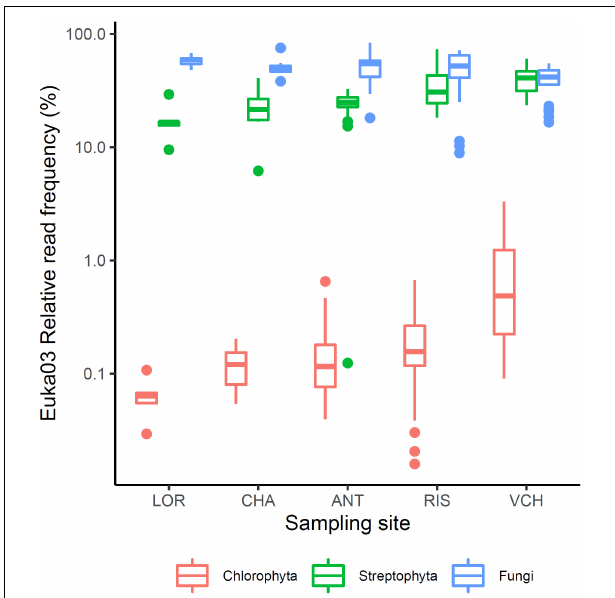
FIGURE 2 | Relative frequencies of three eukaryotic clades; Fungi , Streptophyta , and Chlorophyta , among the sampling sites. The lower and upper limits of the boxes correspond to the first and third quartile, respectively, while the bold center line marks the median. The whiskers delineate the confidence interval defined as 1.5 times the difference between the first and third quartile. Outlier PCRs ranging outside of that interval are marked with dots.